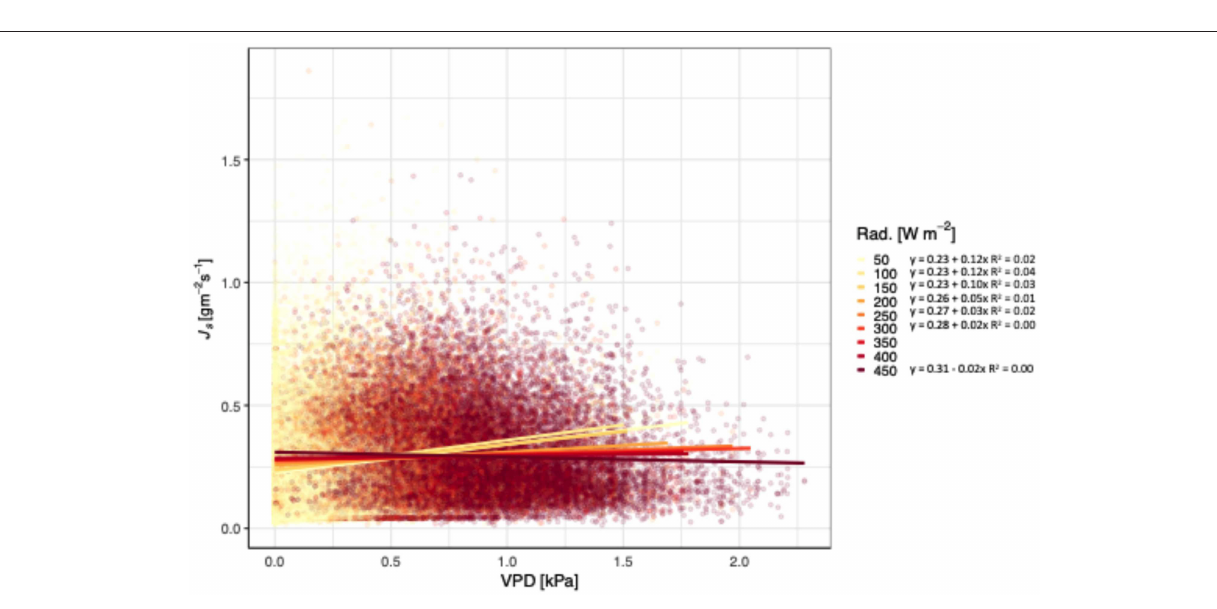
FIGURE 3 | Relationship between vapor pressure deficit (VPD; kPa), sap flux density ( J s ; gm − 2 s − 1 ), and net radiation (Rad. Wm − 2 ) for Tectona grandis . Treatments (thinned and unthinned) are pooled. Colors represent binned hourly mean net radiation (by 50 Wm − 2 ) during daylight hours (07:00 to 18:00). Model equations for each temperature bin shown. R 2 values included for all models where p <